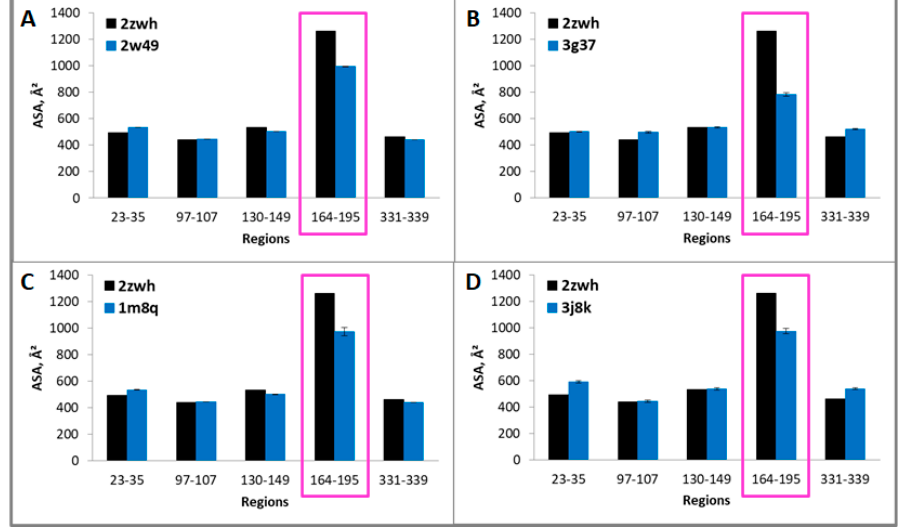
Figure 5. Accessible surface areas of regions 23–35, 97–107, 130–149, 164–195, and 331–339 for monomeric (2zwh) and filamentous (2w49—16 monomers ( A ), 3g37—12 monomers ( B ), 1m8q—14 monomers ( C ), 3j8k—10 monomers ( D )) actin structures. These regions detected by using mass